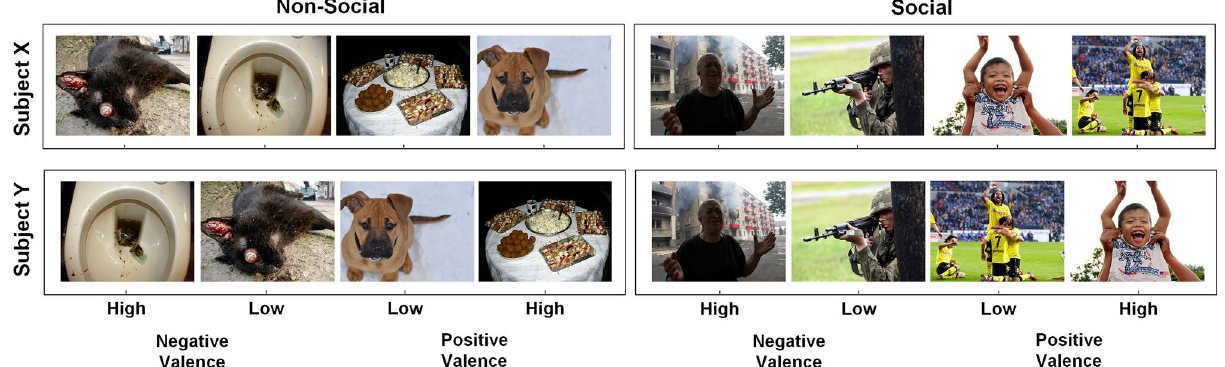
Figure 1. Example of differential picture ratings among two exemplary subjects. Participants individually rated the ‘sociality’ and ‘valence’ of a set of 36 stimulus pictures (here, only 8 exemplary pictures are shown; see Supplementary Fig. 1 for the full stimulus set) to obtain a person-dependent scoring of the perceived social/ non-social nature of the presented stimuli, as well as the stimuli’s perceived emotional evocativeness (high, low) in terms of positive/negative valence. For example, a picture of a winning football team can be anticipated to be rated with high positive valence by a person who loves sports (exemplary subject X), whereas the same picture may be rated more neutral (low positive valence) by another subject (exemplary subject Y). Likewise, for a person who owns a cat, a picture of a dead cat may evoke stronger negative valence than the picture of the dirty toilet (exemplary subject X), whereas for others, this may be the other way around (exemplary subject Y). All pictures were selected from the publicly available Nencki Affective Picture System database (NAPS 21 lus set of pictures was presented in a semi-random order and participants were informed that they could either prolong or shorten the viewing time of each presented stimulus by pressing the ‘up’ or ‘down’ arrow key on a key- board, respectively. The viewing time was adjusted in real-time according to the formula: New Total Time = Old Total Time + (Extreme Time – Old Total Time)/K. The Extreme Time was set to 12 s for extending the viewing time and to 0 s for shortening the viewing time; K was a scaling constant set to 40 (similar paradigm as adopted in 13 and based on 35 ). Accordingly, an up or down key press prolongs or shortens the viewing time with respec- tively, 0.15 s (firs key press); 0.146 (second key press), 0.142 (third key press); 0.139 (fourth key press); etc. If par- ticipants did not press any arrow key, the stimulus presentation was discontinued after 6 s. In order to avoid the approach/avoidance was obtained by assessing the total sum of ‘up’ (positive value) and ‘down’ (negative value) key presses. Accordingly, a positive total sum-score indicates a higher number of ‘up’ key presses (i.e., prolonging the viewing time, indicative of approach) and a negative total sum score, indicates a higher number of ‘down’ key presses (i.e., shortening the viewing time, indicative of avoidance). The average total sum score (across partici- pants and stimuli) was 0.8 ± 11.06 (mean ± SD), meaning that, on average, participants prolonged the stimulus viewing time with one ‘up’ key press, to an average picture viewing time of 6.15 s.